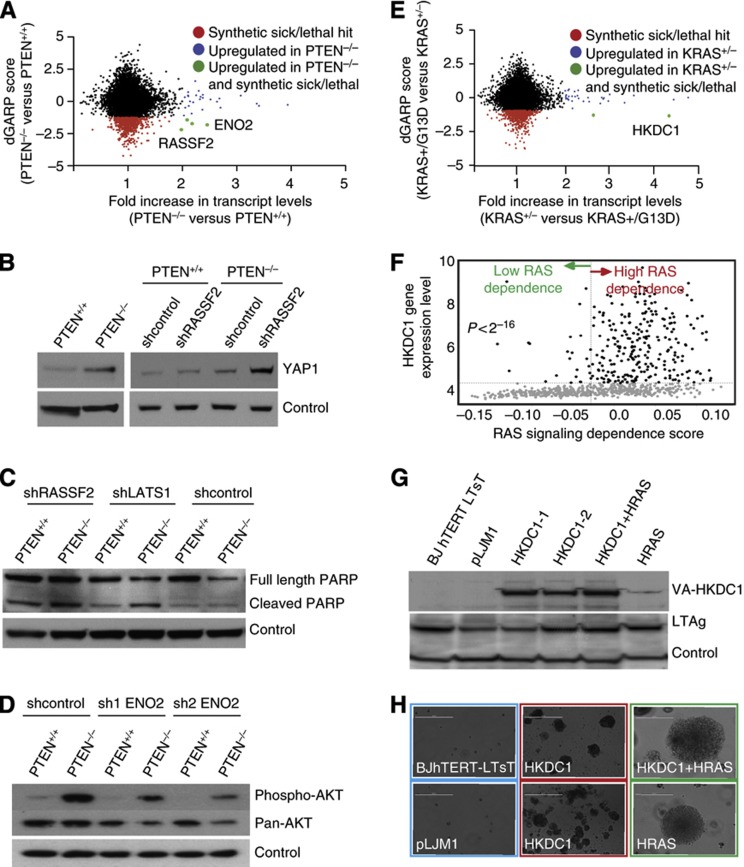
Differential essentiality versus differential expression. (A) Scatter plot of fold-change in transcript levels in PTEN−/− cells compared with PTEN+/+ cells (x axis) versus dGARP (y axis). The red points indicate genes that are SSL with the PTEN−/− genotype, the blue color indicates genes that are highly expressed in PTEN−/− cells versus PTEN+/+ cells, and the green color indicates genes that are synthetic lethal and increased in expression in the mutant PTEN−/− cells. (B) Western blotting of YAP1 protein levels in PTEN+/+ and PTEN−/− cells infected with shRNA against LacZ or RASSF2. (C) Western blot of PARP cleavage levels in PTEN+/+ and PTEN−/− cell lines after cisplatin treatment in indicated knockdown conditions. (D) Western blot of phospho-AKT and pan-AKT levels in PTEN+/+ and PTEN−/− cells infected with shRNA against LacZ or ENO2. (E) Scatter plot of fold change in transcript levels in KRAS+/− compared with KRASG13D lines against the differential essentiality score (dGARP score). The red color indicates genes that are synthetic lethal, the blue color indicates genes that are highly expressed in KRAS+/− cells and the green color indicates genes that are synthetic lethal and increased in expression in the KRAS+/− lines. (F) RAS signaling dependence score versus HKDC1 expression in CCLE data sets. Vertical line separates high and low RAS signaling dependence; horizontal line separates HKDC1 ‘expressed' and ‘expression uncertain'. Top-right quadrants contain overabundance of samples with clear HKDC1 expression and high RAS dependence. P<2.2 × 10−16 calculated using Fisher's exact test. (G) Western blot analysis showing the overexpression of HKDC1 tagged C-terminally with the VA affinity tag and the LargeT antigen in different backgrounds. (H) Colony-formation assay in soft agar for HKDC1 overexpression. GFP (pLJM1) and HRASG12V were used as negative and positive controls.